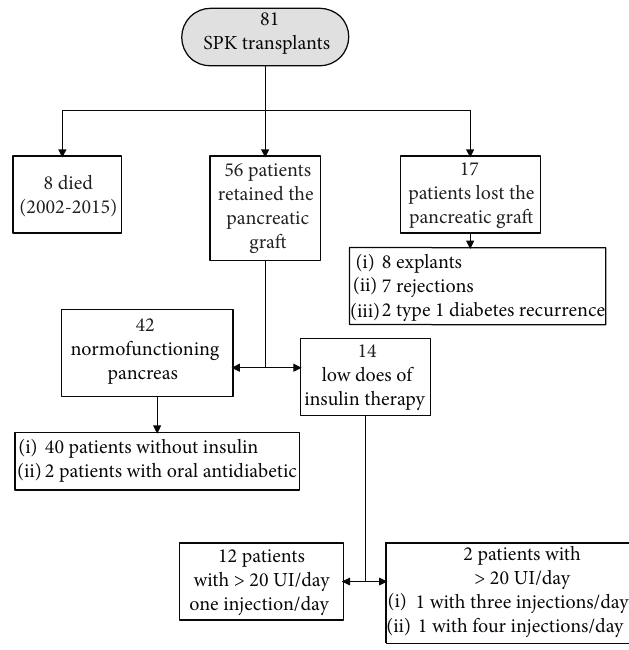
Figure 1: SPK transplant